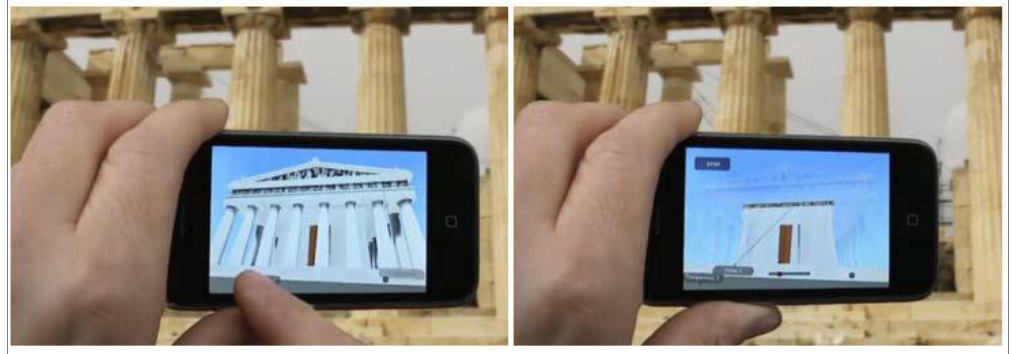
Figure 7 Parthenon Temple, Zooming-in and Transparency in AR (Liestøl, 2011)